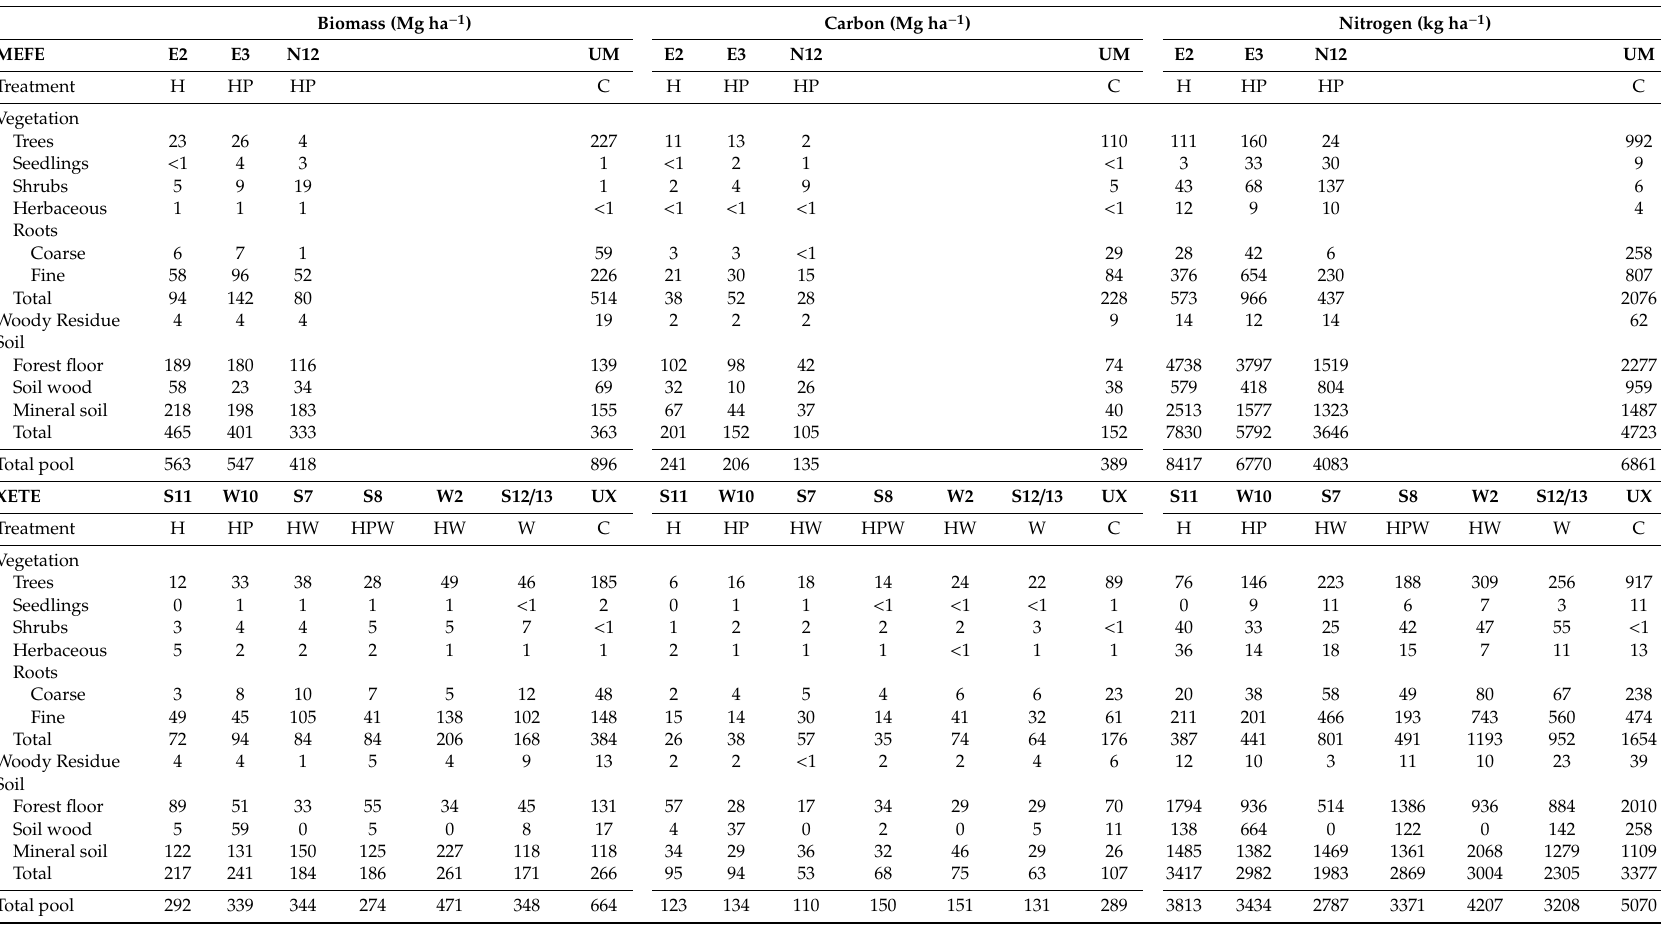
Table 4. Thirty-year post-treatment measures of total biomass and carbon and nitrogen pools for the two phases ( Menziesia ferruginea , MEFE; Xerophyllum tenax , (see Table 1 for descriptions). For treatments: H = harvested; P = prescribed fire; W = wildfire; C =